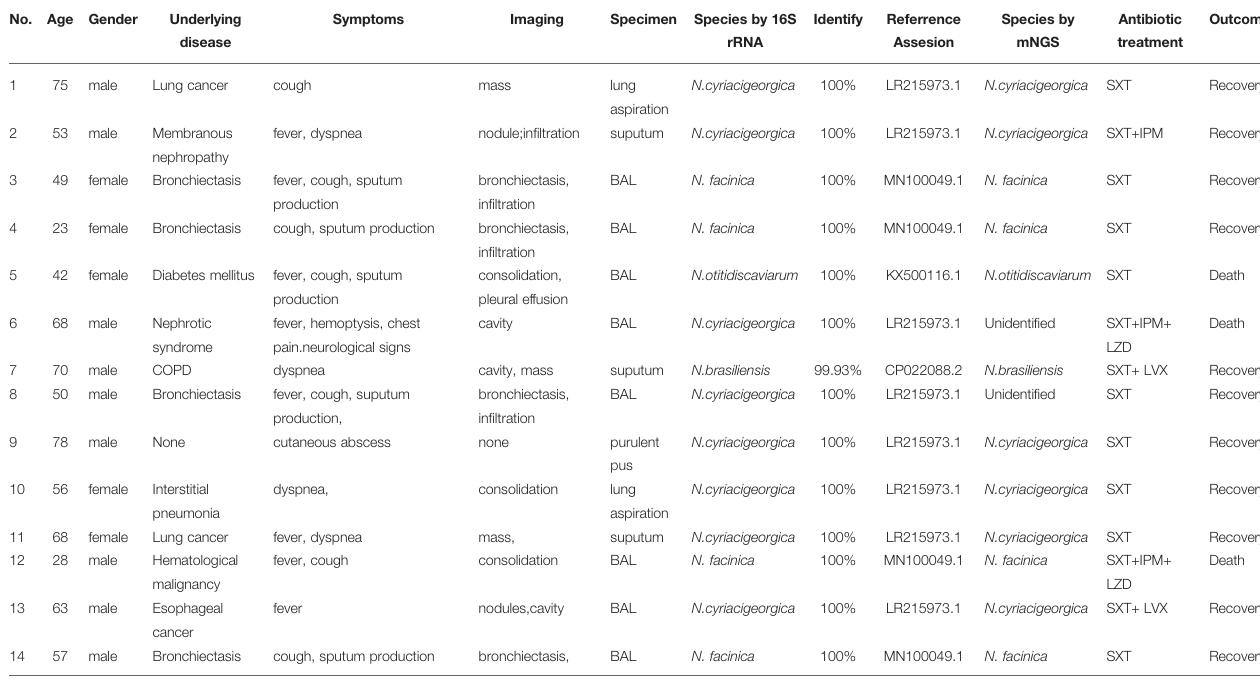
TABLE 1 | Clinical features of the patients and Nocardia strains isolated from samples. No. Age